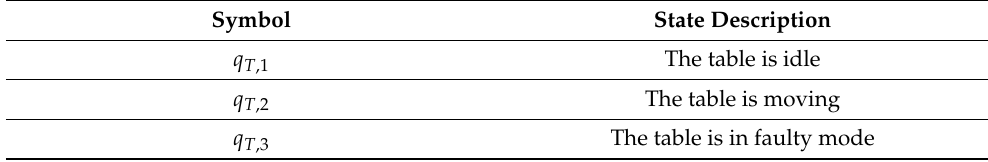
Table 2. Events of the circular rotating table. Symbol Event Description e T ,1 The table starts rotating for 90 o e T ,2 The table stops rotating e T ,3 A fault took place e T ,4 The fault has been